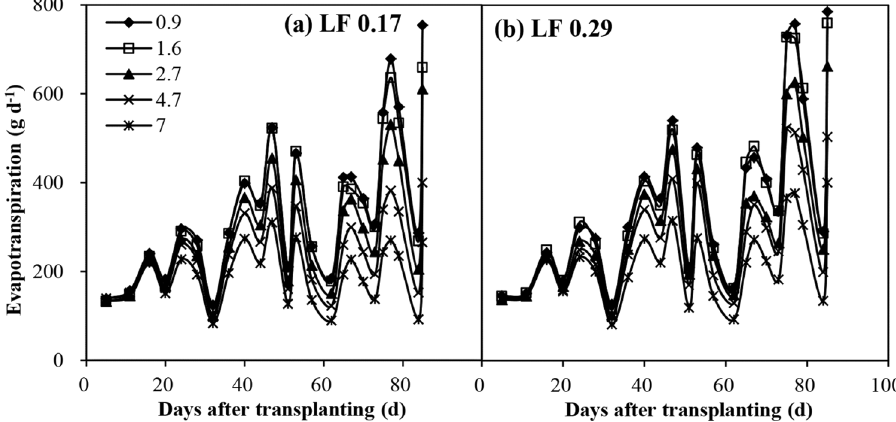
Figure 4. Temporal fluctuation in daily evapotranspiration (ET) throughout the growth season under various irrigation water salinity levels and leaching fractions (LF).